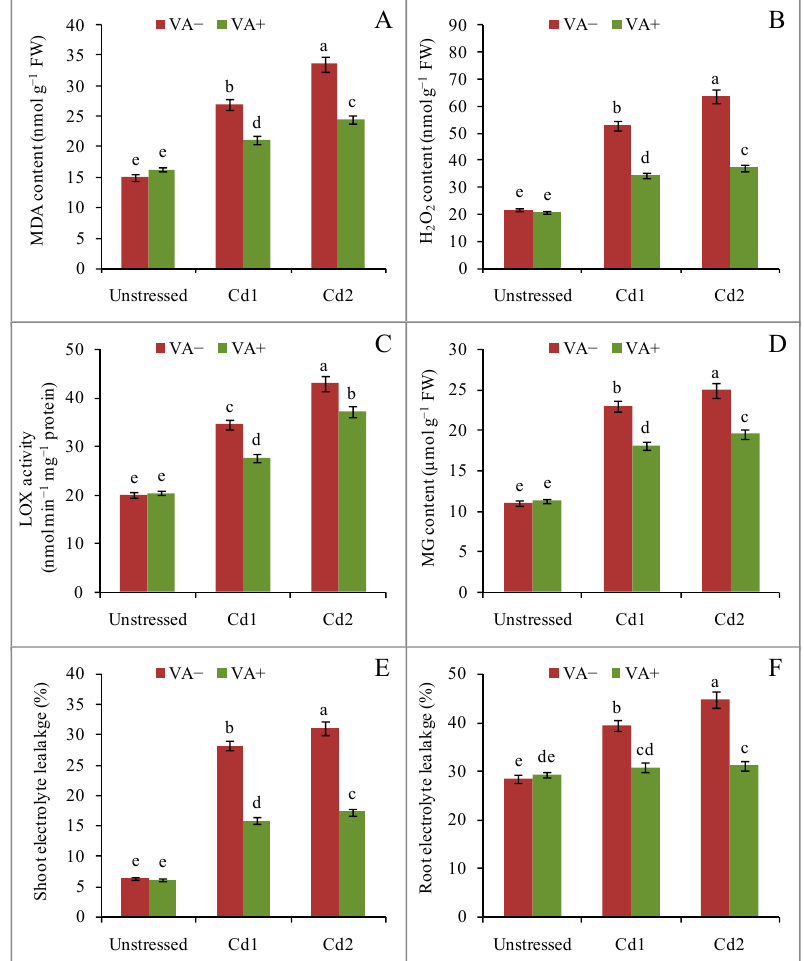
Figure 4. Effects of exogenous VA on malondialdehyde (MDA)( A ) and H 2 O 2 ( B ) content, lipoxygenase (LOX) activity ( C ), methylglyoxal (MG) content ( D ), and electrolyte leakage (EL) of shoot ( E ) and root ( F ) of rice ( Oryza sativa L. cv. BRRI dhan54) seedlings under Cd stress. Mean (±SD) was computed from three replications of each treatment. Bars with dissimilar letters are significantly different at p ≤ 0.05 from Fisher’s least significant difference (LSD) test .